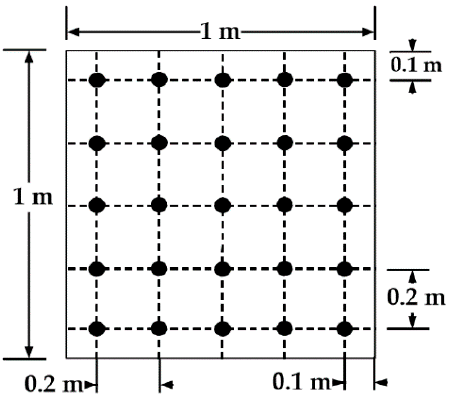
Figure 3. Fixed positions of the 25 illumination measurements on the floor plane.